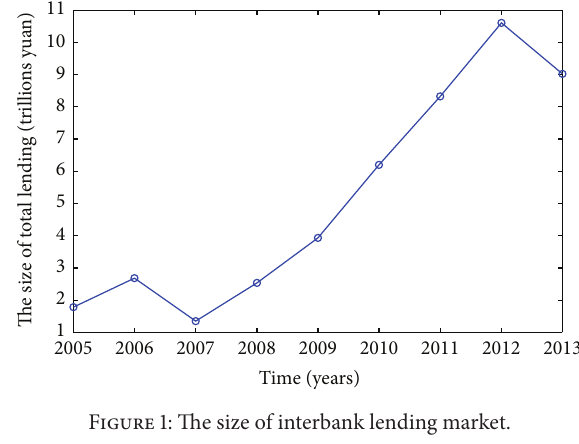
Figure 1: The size of interbank lending market.